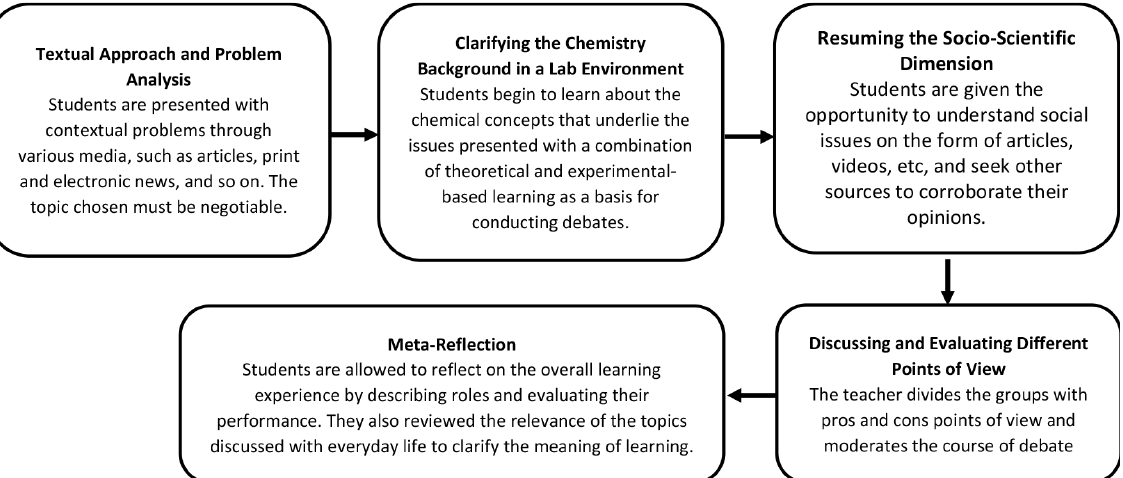
Figure 2. Socio-Critical and Problem-Oriented Learning Stages (Feierabend & Eilks, 2011)